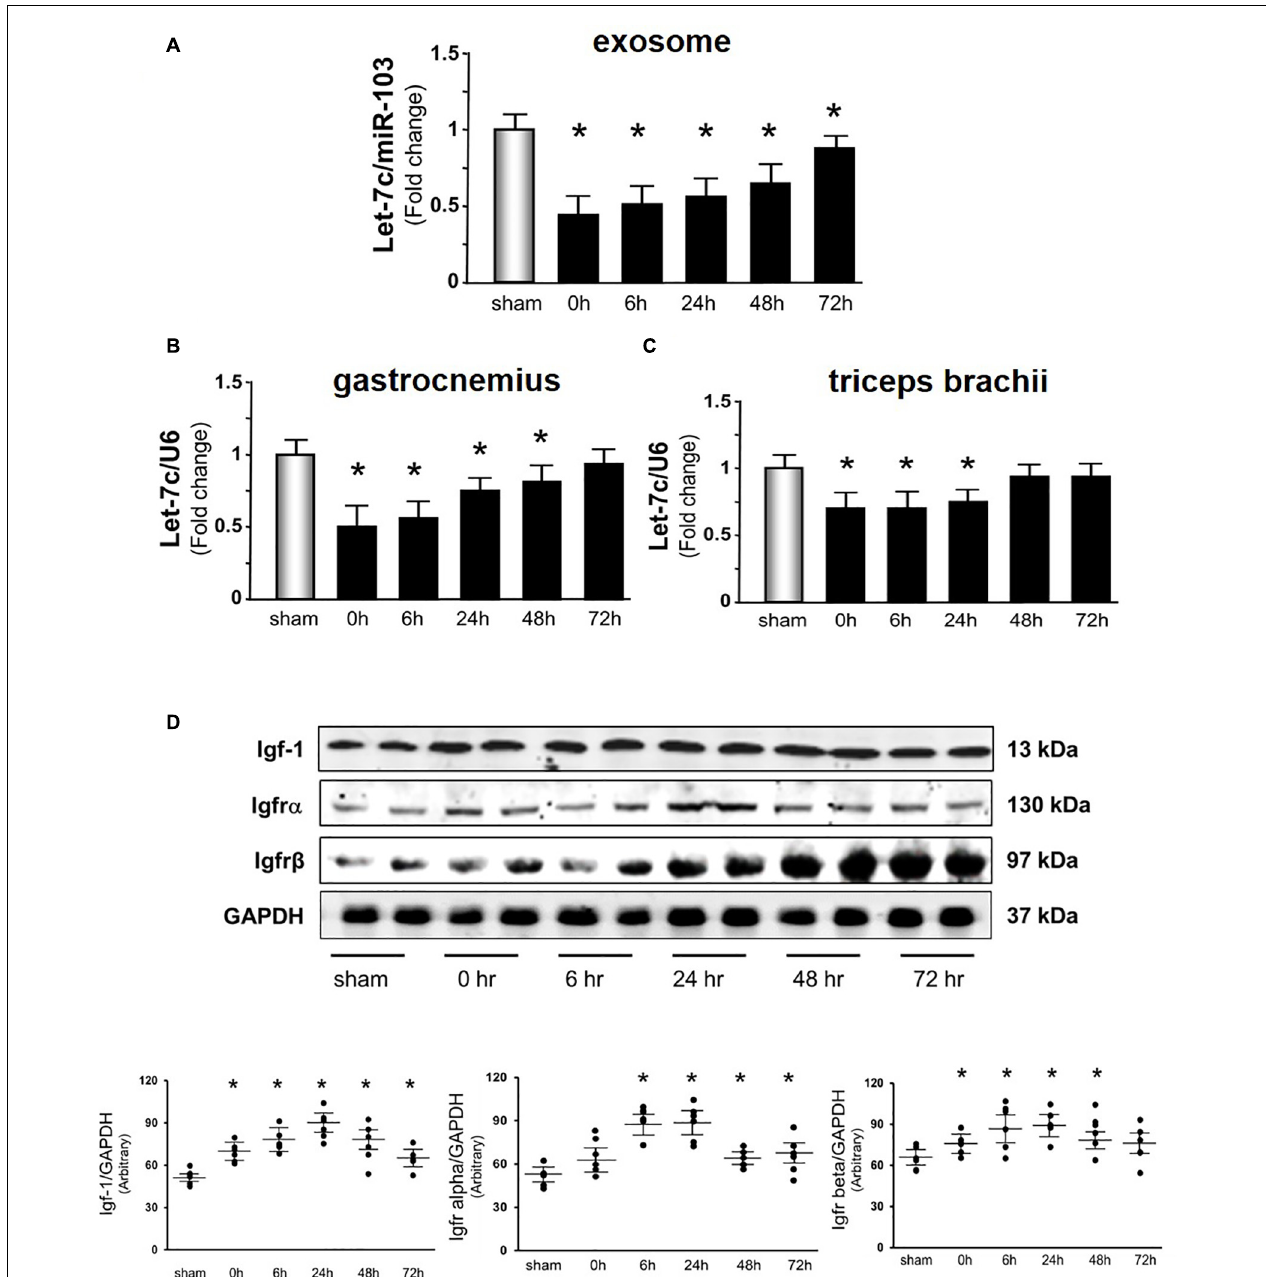
FIGURE 4 | Acu/LFES decreased let-7 in serum exosome and skeletal muscles. Total RNA was isolated from serum exosomes (A) , gastrocnemius muscle (B) and triceps brachii muscles (C) of sham and Acu/LFES treated mice. The expression of let-7c-5p was assayed by real time qPCR. The bar graph shows microRNA from the exosomes of Acu/LFES mice compared with levels in shams (defined as onefold). Results are normalized to miR-103a for serum and U6 for muscle (Bars: mean ± SE.; n = 6/group; * p < 0.05 vs. sham). (D) Protein was isolated from gastrocnemius muscle. Igf1, Igfr α and Igfr β measured by Western blots. The point graph of protein showed the change of the density of proteins normalized to their corresponding GAPDH protein Data is provided in arbitrary units. ( n = 6/group; * p < 0.05 vs.